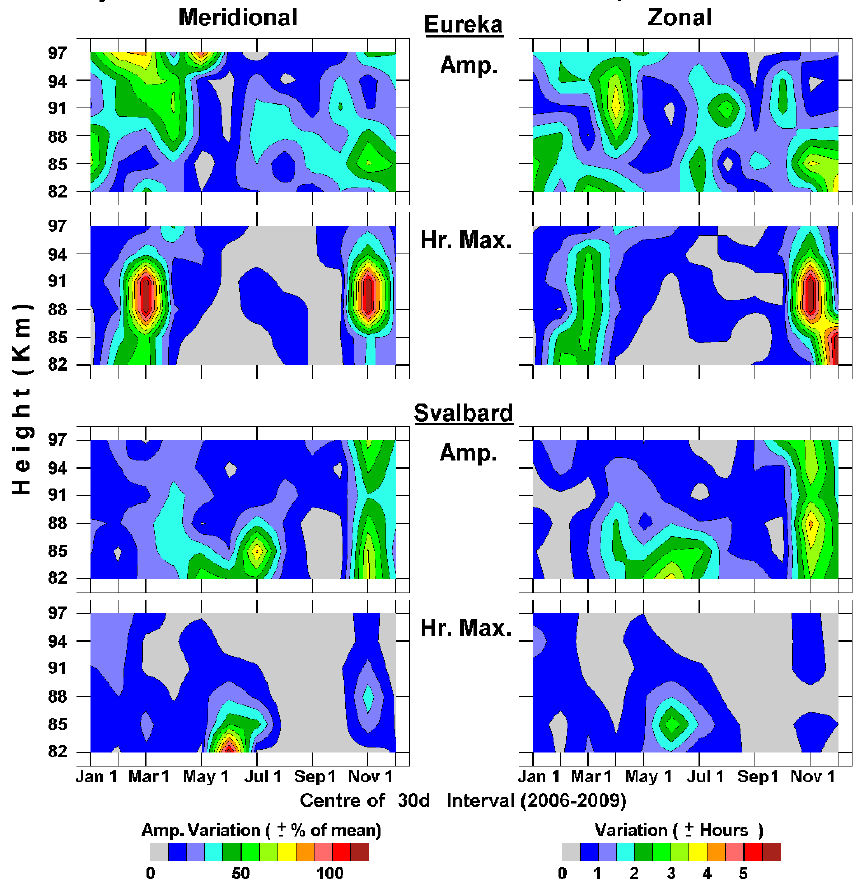
Fig. 6. The “variation” of 12-h tidal amplitudes and of phases (local times of maximum), over three years (February 2006 to February 2009), are provided. The “variation” of amplitude is [100(maximum − minimum)/(maximum + minimum)]%, and “variation” of phase is hours: [(maximum − minimum)/2]). Separate calculations for amplitudes and phases were done for the tides.